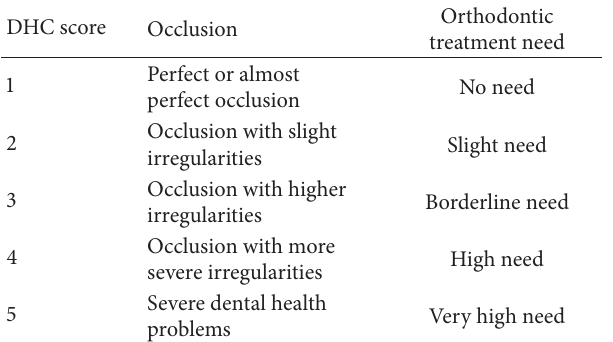
Table 1: Description of the degrees of the IOTN (DHC score). Table 2: Prevalence of the aesthetic component (AC) of the IOTN in the two groups, with the indication of significant